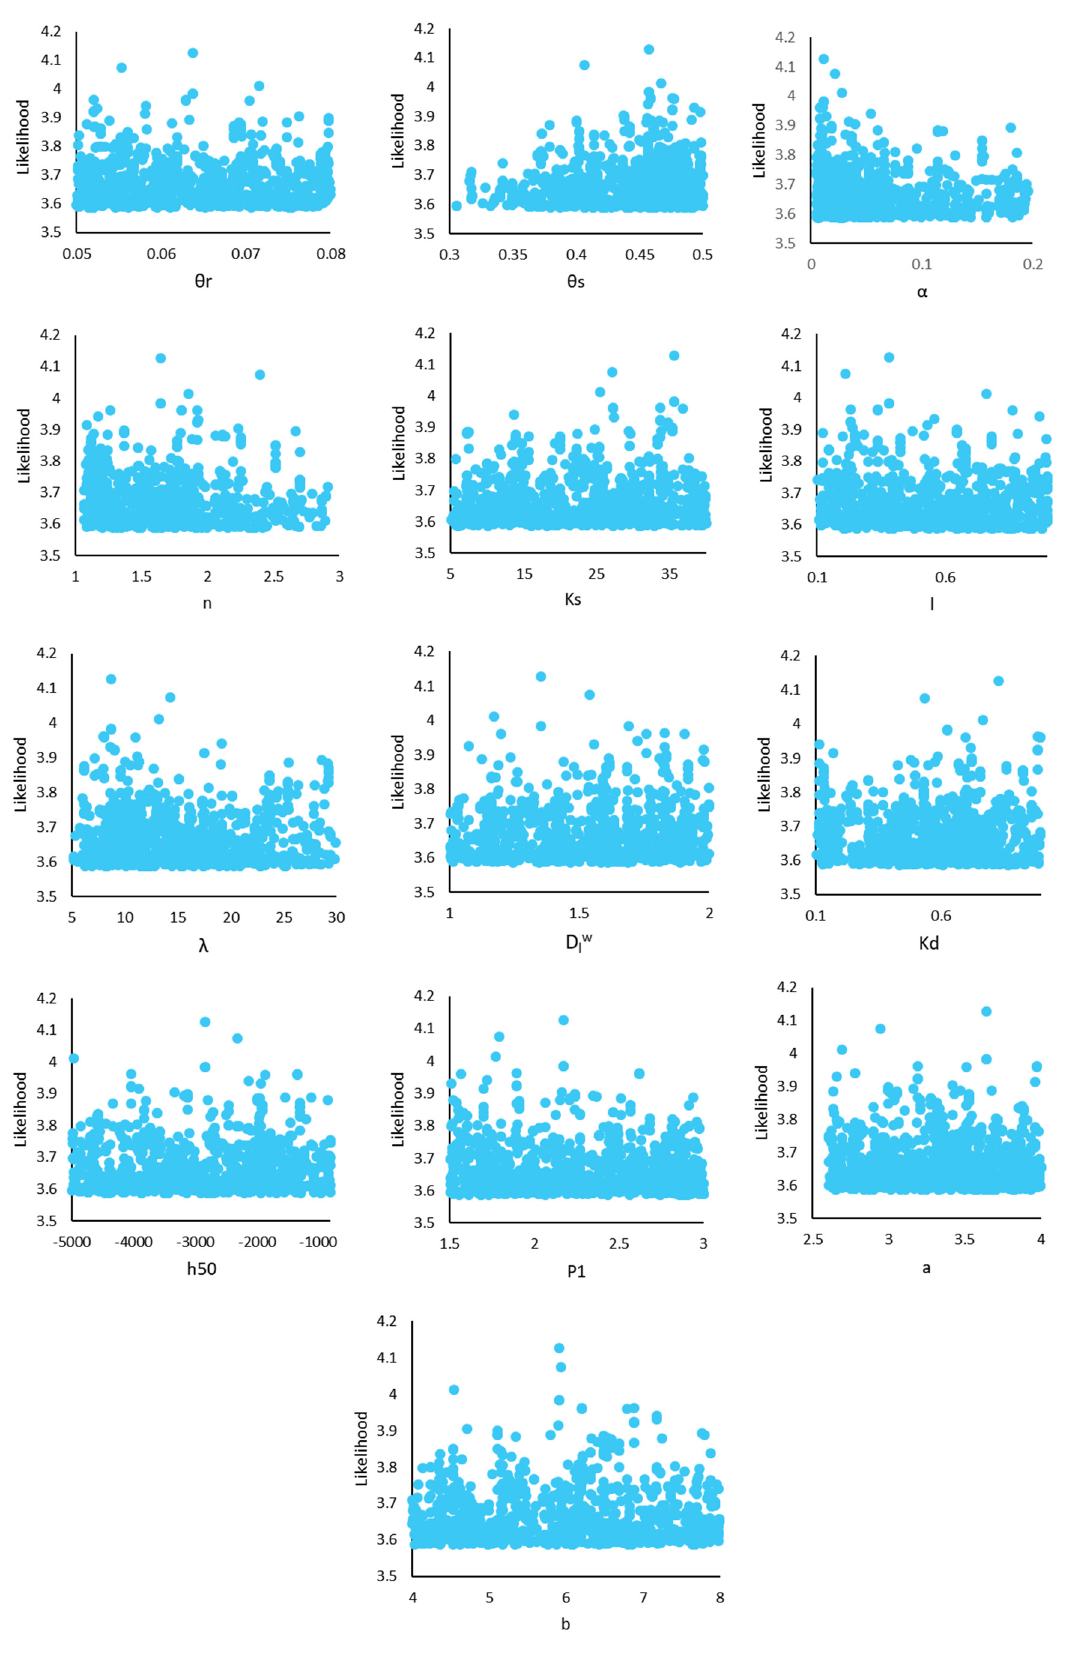
Figure 5. Scatterplots of likelihood values vs. the parameters of the HYDRUS-1D model.